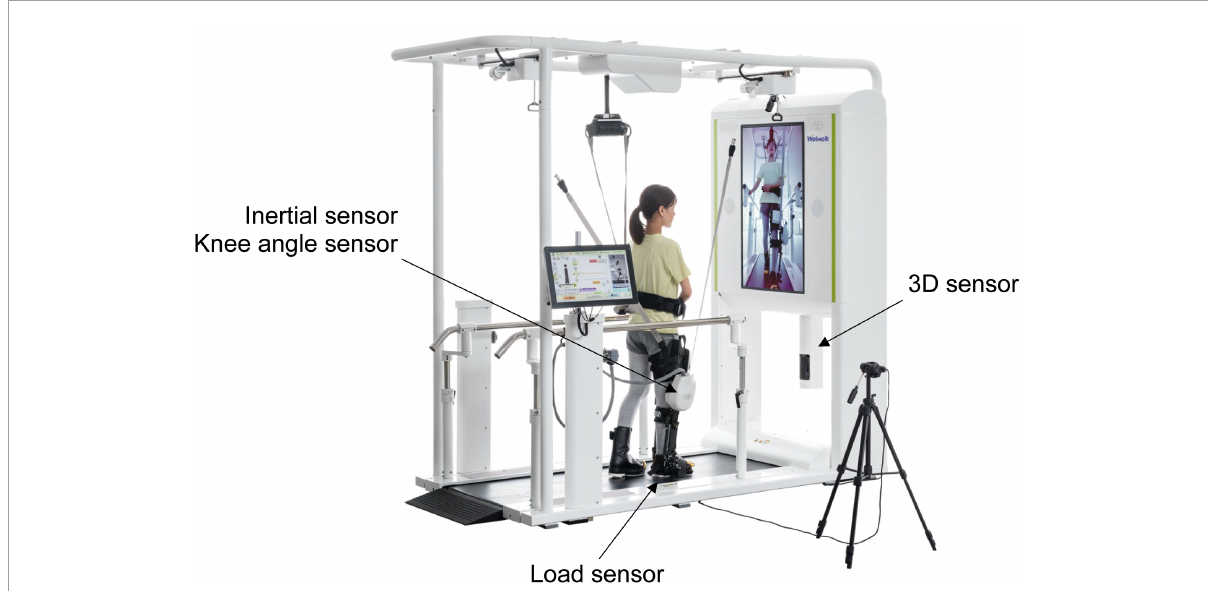
FIGURE1 Overview of the Welwalk WW-2000. The three-dimensional (3D) sensor is placed below the front monitor at 0.6 m from the treadmill surface, and the distance between the sensor and object was 1.2 m. The 3D sensor, inertial sensor, and knee angle sensor are calibrated with the participants in an upright posture before walking. The load sensor is calibrated before the robot is attached to the participants.